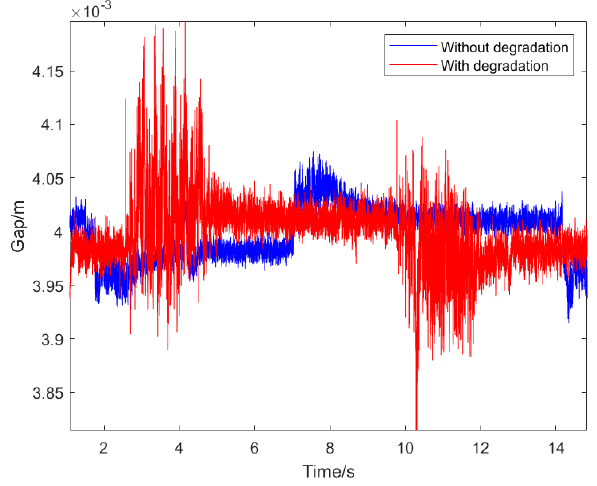
Figure 7. Gap ( a ) and residual ( b ) when the load fluctuates.